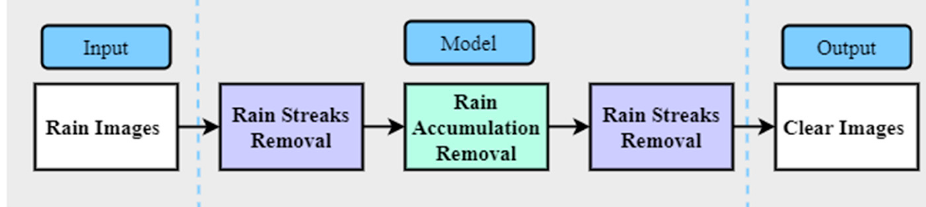
Figure 1. Proposed deraining framework.